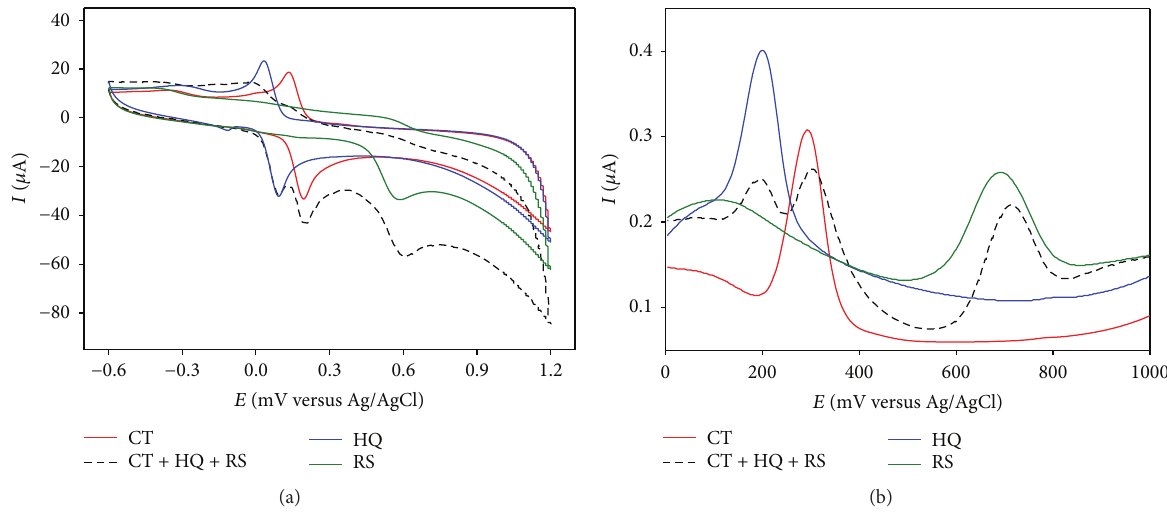
Figure 5: Overlay of (a) CV and (b) DPV responses of individual (solid lines) and ternary mixture (dashed line) of CT, HQ, and RS in PBS at PGA modified